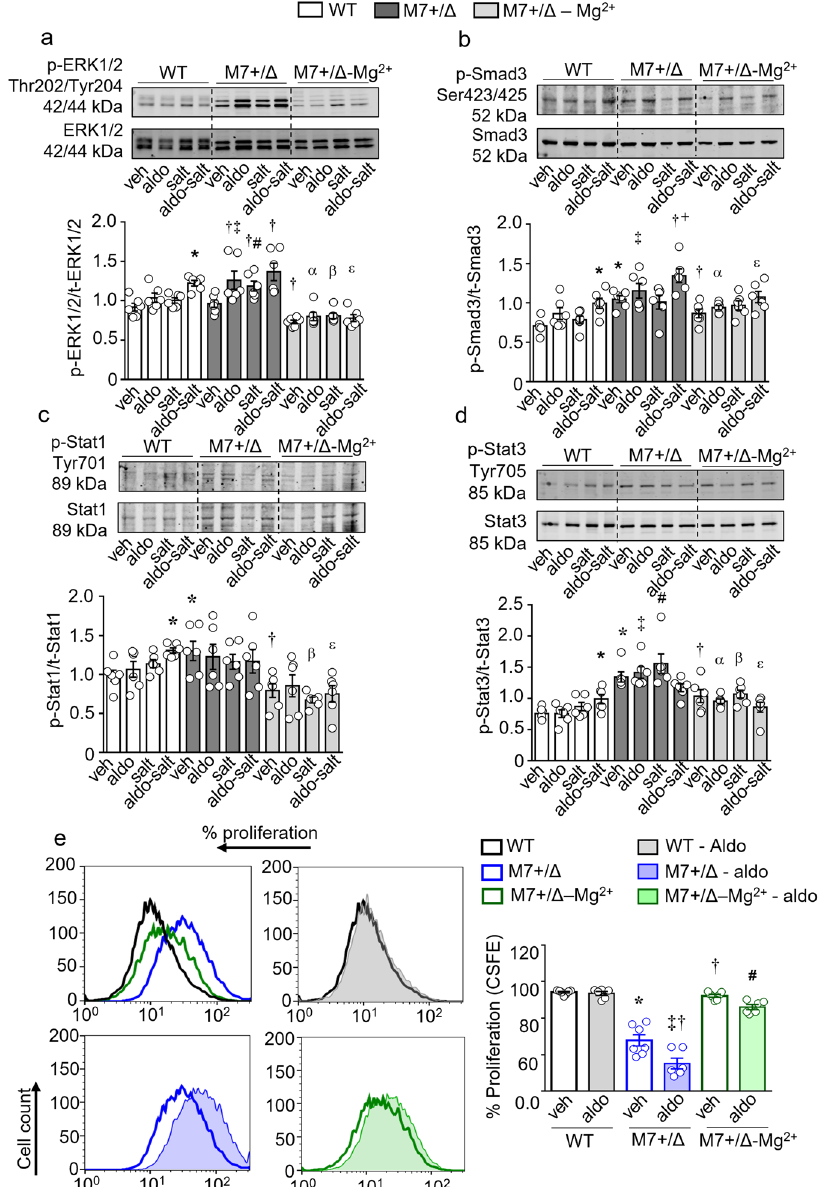
Fig. 7 Cardiac fi broblasts from TRPM7 + / Δ kinase exhibit aberrant activation and proliferation by Mg 2 + dependent mechanisms. Cardiac fi broblasts were isolated from WT and TRPM7 + / Δ kinase (M7 + / Δ ) animals. Part of the cells from M7 + / Δ animals were constantly treated with 10 mM of MgCl 2 . 24 h before the experiments, medium was changed to 1% FBS and part of the cells were treated with NaCl 40 mM or osmotic control Choline Chloride (40 mM). Cells were stimulated with aldosterone (10 − 7 mmol/L) for 10 min. Expression of a phospho-ERK1/2 (Thr202/Tyr204), b phospho-Smad3 (Ser423/425), c phospho-Stat1(Tyr701) and d phospho-Stat3(Tyr705) was assessed by immunoblotting and normalized by total forms of Smad3, ERK1/2, Stat1, and Stat3. e Cardiac Fibroblasts were labeled with CFSE and stimulated with aldosterone (10 − 7 mmol/L). Proliferation was accessed by fl ow cytometry after 96 h. Data are expressed as mean ± SEM and representative fi gures ( n = 7/group). One-way ANOVA followed by Dunnett ’ s multiple comparisons test were used for statistical analysis. * P < 0.05 vs WT veh; † p < 0.05 vs M7 + / Δ veh; ‡ p < 0.05 M7 + / Δ aldo vs WT aldo; # p < 0.05 M7 + / Δ salt vs WT salt; α p < 0.05 M7 + / Δ -Mg 2 + aldo vs M7 + / Δ aldo; β p < 0.05 M7 + / Δ -Mg 2 + salt vs M7 + / Δ salt; ε p < 0.05 M7 + / Δ -Mg 2 + aldo-salt vs M7 + / Δ Moreover, we found increased frequency of CD8 cytotoxic T cells, which induce tissue damage by the production of granzymes. These fi ndings are in line with previous in vitro data in HEK cells expressing TRPM7 kinase-de fi cient mutants, which have increased aldosterone-induced MAPK activation, ICAM-1 expression, and ROS production 27 . ylation of Stat1 and expression of TGF β , which were already